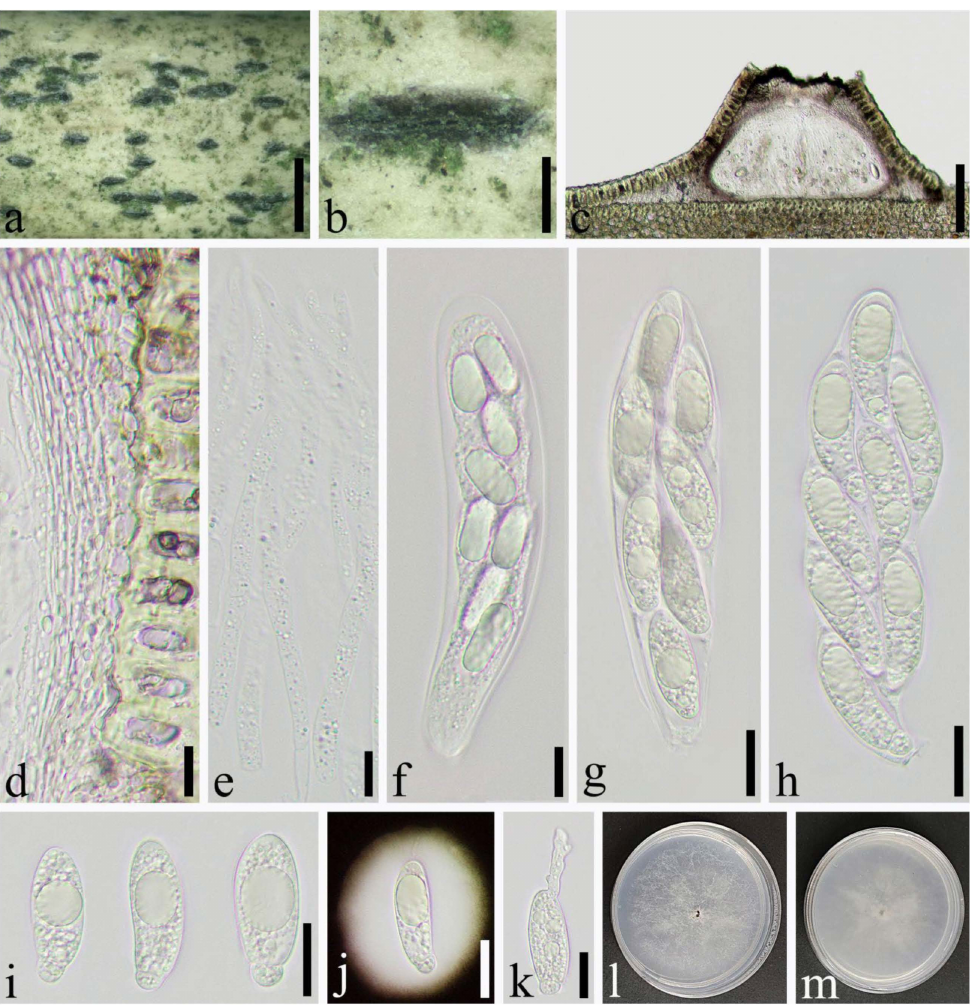
Figure 8. Apiospora yunnana (SICAU 22-0072). ( a , b ) Ascostromata developing on bamboo culm. ( c ) Vertical sections of ascostromata. ( d ) Peridium. ( e ) Paraphyses. ( f – h ) Asci. ( i , j ) Ascospores. ( k ) Germinating ascospore. ( l , m ) Cultures on PDA. Scale bars: ( a ) = 2 mm, ( b ) = 500 µ m, ( c ) = 100 µ m, ( d – f ) = 10 µ m, ( g – k ) = 20 µ